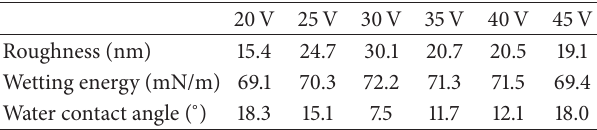
Table 1: Roughness, wetting energy, and water contact angle of TNAs prepared at different anodizing